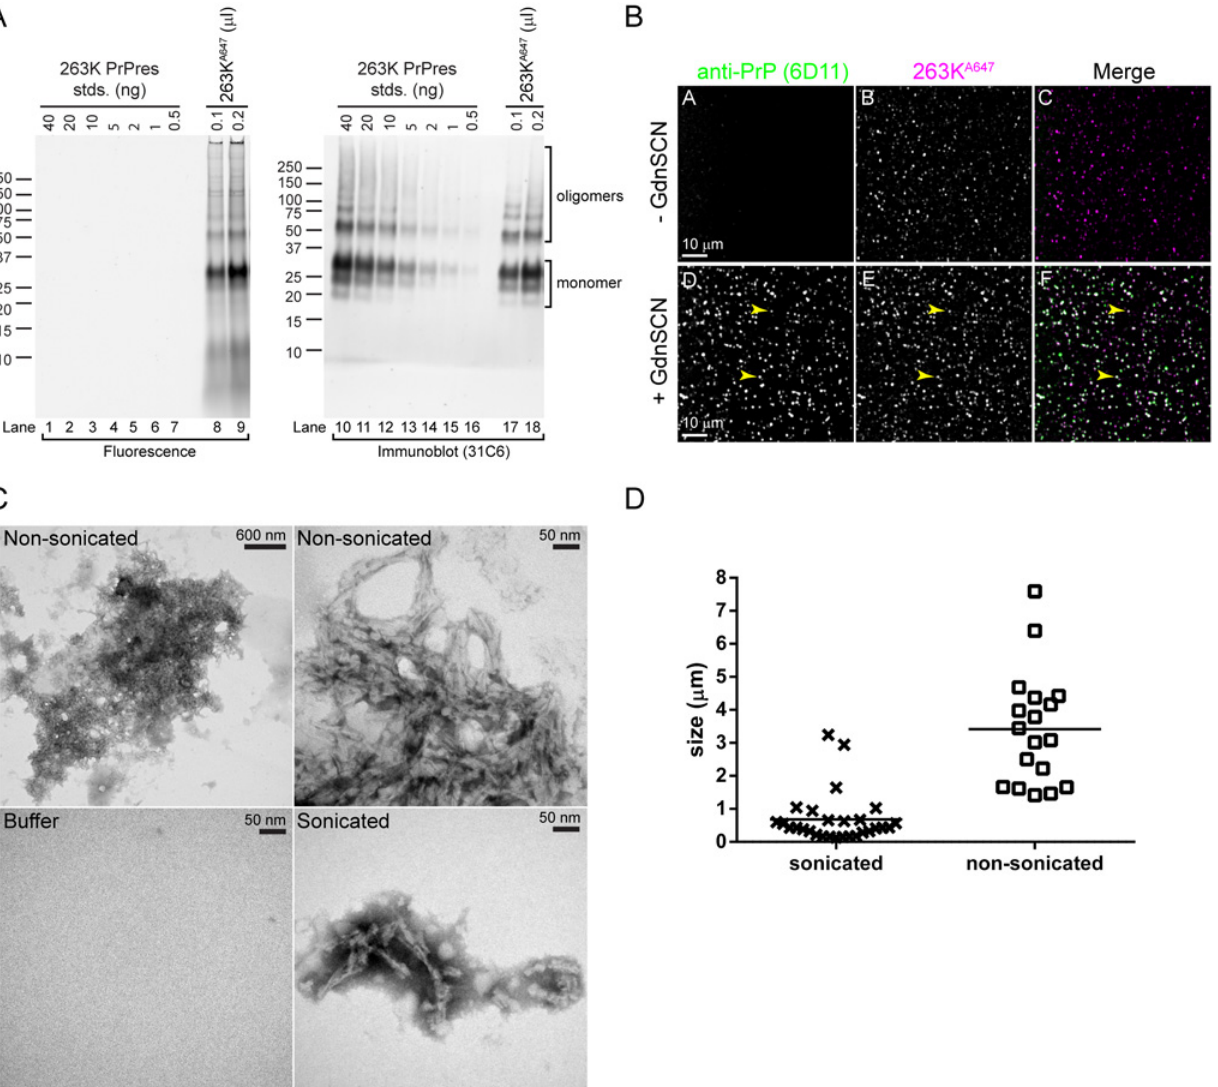
Fig 1. Characterization of 263K PrPres preparations covalently labeled with Alexa Fluor 647 (263K A647 ). (A) Fluorescent bands in 263K A647 are PrP. 263K A647 was resolved by SDS-PAGE. The gel was scanned to detect the fluorescent bands (Fluorescence) before immunoblotting with anti-PrP 31C6 (Immunoblot). Known quantities of unlabeled 263K PrPres were loaded as standards (lanes 1 – 7 and 10 – 16) for immunoblot quantitation of 263K A647 . Fluorescent bands corresponding to 31C6-immunoreactive species constituted > 85 – 90% of the total fluorescence. (B) Fluorescent particles in 263K A647 preparations all contain PrPres. Sonicated 263K A647 was spotted onto coverslips and immunostained with anti-PrP 6D11 with or without pretreatment with 3 M GdnSCN. All fluorescent 263K A647 particles (magenta) exhibited GdnSCN-dependent immunolabeling (green) indicative of PrPres. Merge, white indicates co-localization with equal signal from each channel. Arrowheads indicate examples 263K A647 particles with co-localized immunolabeling. (C) Electron micrographs of 263K A647 aggregates. Samples of 263K A647 before (Non-sonicated) and after (Sonicated) sonication were examined by TEM. Images of a non-sonicated aggregate acquired at low and high magnification are shown to allow visualization of the entire aggregate (upper left) and its composition (upper right). Buffer, buffer only control. (D) Analysis of 263K A647 aggregates in (C). The longest dimension of randomly selected aggregates in TEM images was measured and plotted. The mean size ± standard deviation for sonicated and non-sonicated 263K A647 aggregates was 0.683 μ m ± 0.748 μ m (n = 28) and 3.415 μ m ± 1.676 μ m (n = 18), respectively. These differences were statistically significant (P < 0.0001).